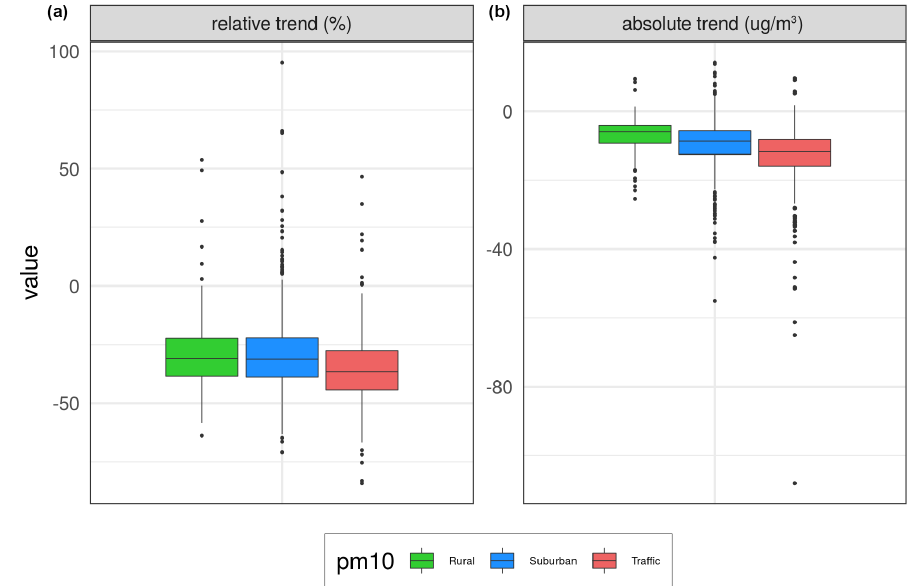
Figure 9. Box plots of changes in expected concentrations over the same three types of stations as in the map plots in Fig. 8. Panel (a) shows relative percent changes, while panel (b) shows absolute changes from 2005 to 2019 (units in % and µgm − 3